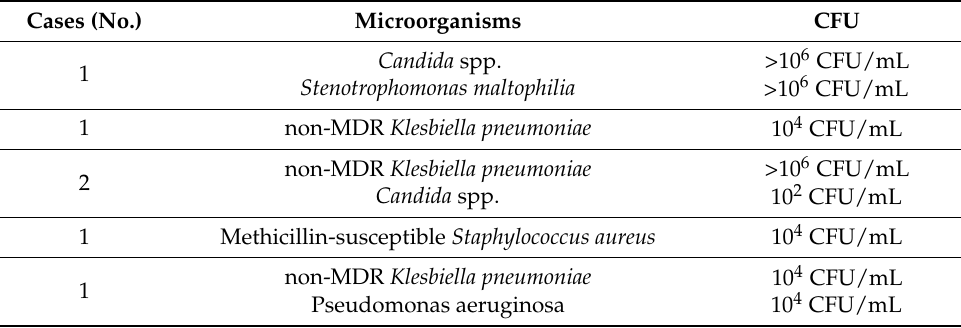
Table 3. Search results for common bacteria and fungi. Cases (No.)